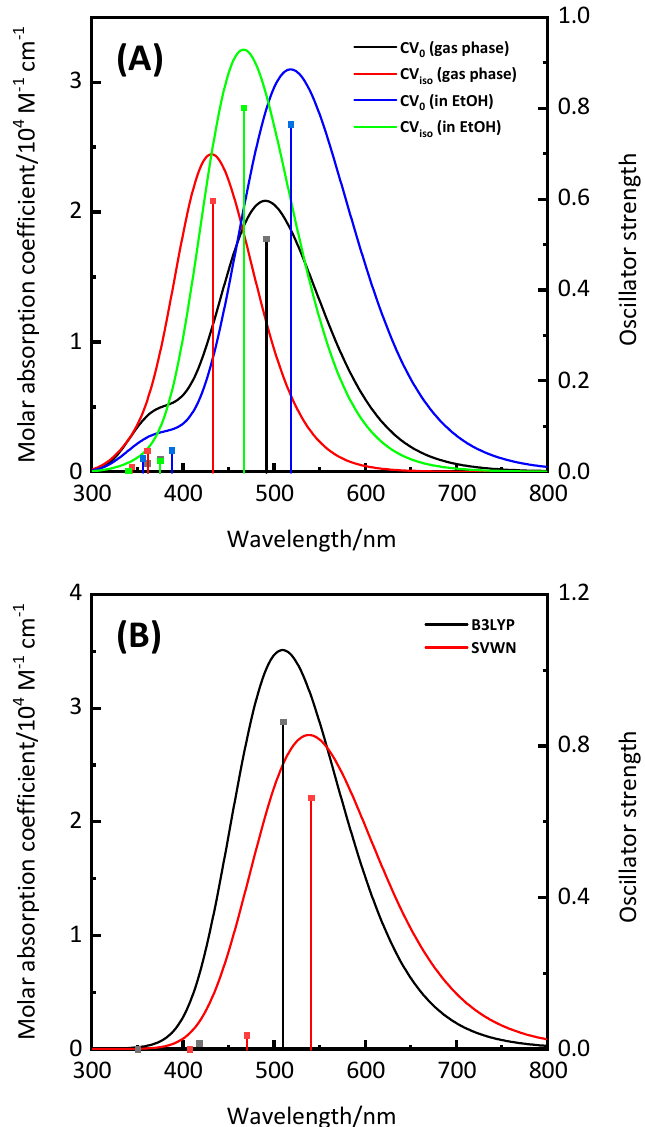
Figure 2. ( A ) Simulated UV-visible absorption spectra of CV 0 and CV iso in the gas phase and / or using CPCM in EtOH, calculated at the TD-B3LYP / 6-31 + G* level of theory; ( B ) simulated UV-visible absorption spectra of CV + using CPCM in EtOH, calculated at the TD-B3LYP / 6-31 + G** (black line) and TD-SVWN / 6-31 + G** (red line) levels of theory, respectively. Vertical lines indicate the calculated oscillator strengths. Table 1. Calculated maximum absorption peaks ( λ max ), molar absorption coefficients ( ε ), energies of singlet excited states ( E S1 ), oscillator strengths ( f ) and light-harvesting efficiencies (LHE) of CV 0 , CV iso and CV + .